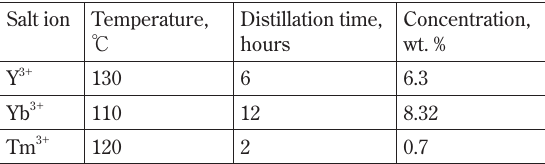
Table 1 Precursor synthesis conditions Salt ion